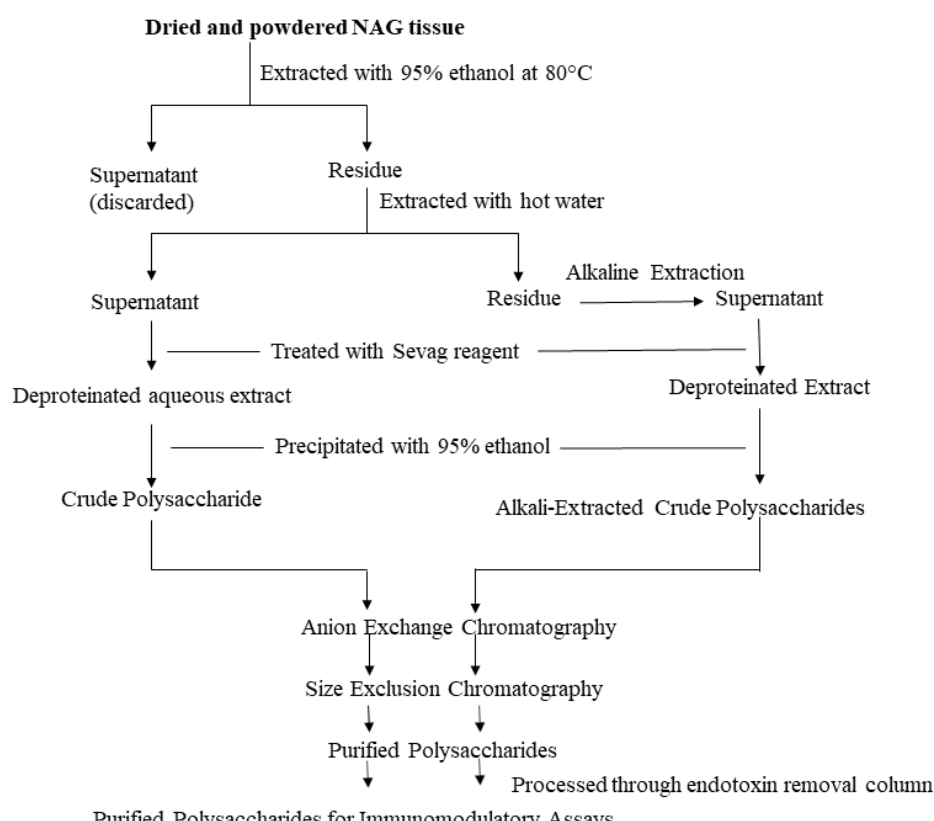
Figure 1. Extraction and Purification Workflow. The illustrated workflow is recommended for the purification of polysaccharides intended for immunomodulatory assays.